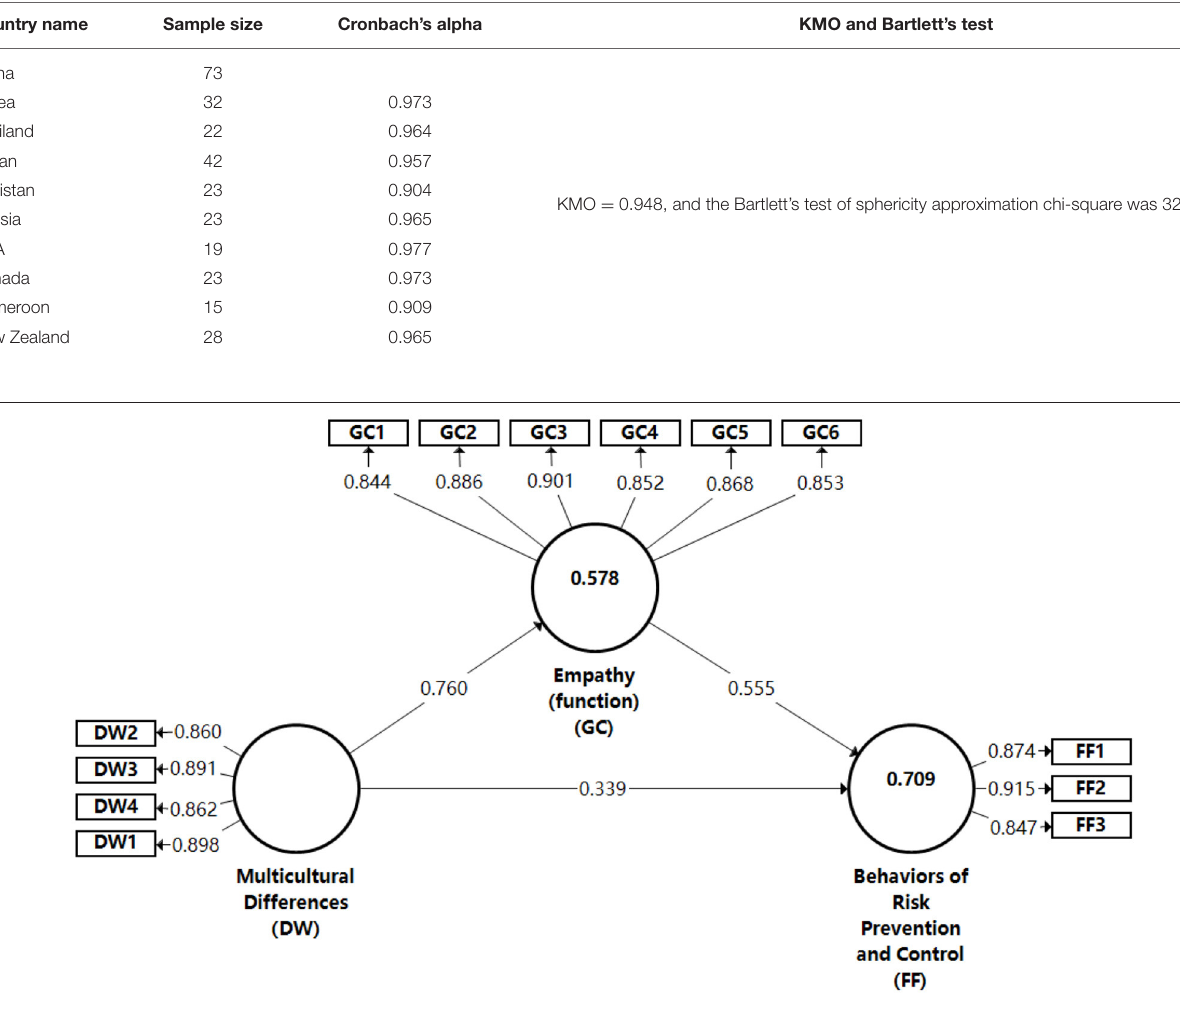
FIGURE 2 | Reflective measurement